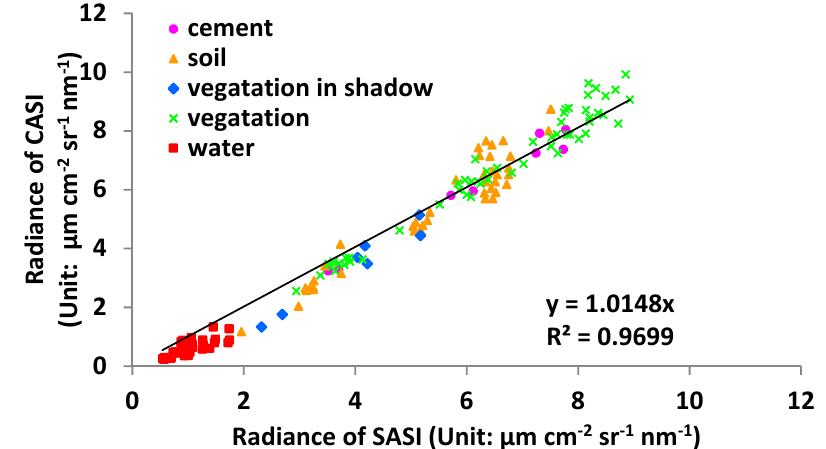
Figure 2. Scatter diagram of the relationship between Compact Airborne Spectrographic Imager (CASI) and SWIR Airborne Spectrographic Imager (SASI) for the three selected overlapping bands for 10 different ROIs.